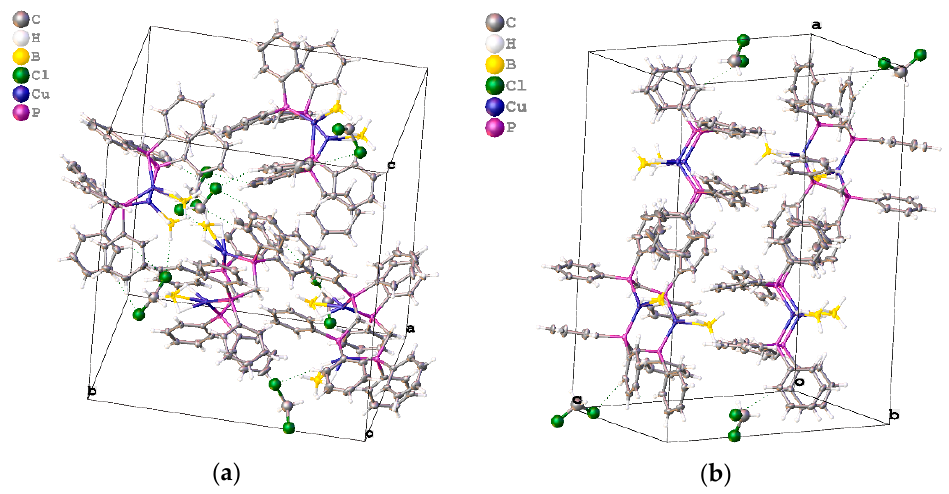
Figure 2. View of molecular packing of 1 (P 2 1 2 1 2 1 ) ( a ) and 2 (P 2 1 /c) ( b ) in a unit cell. Table 3. Selected structural parameters for 1 and 2